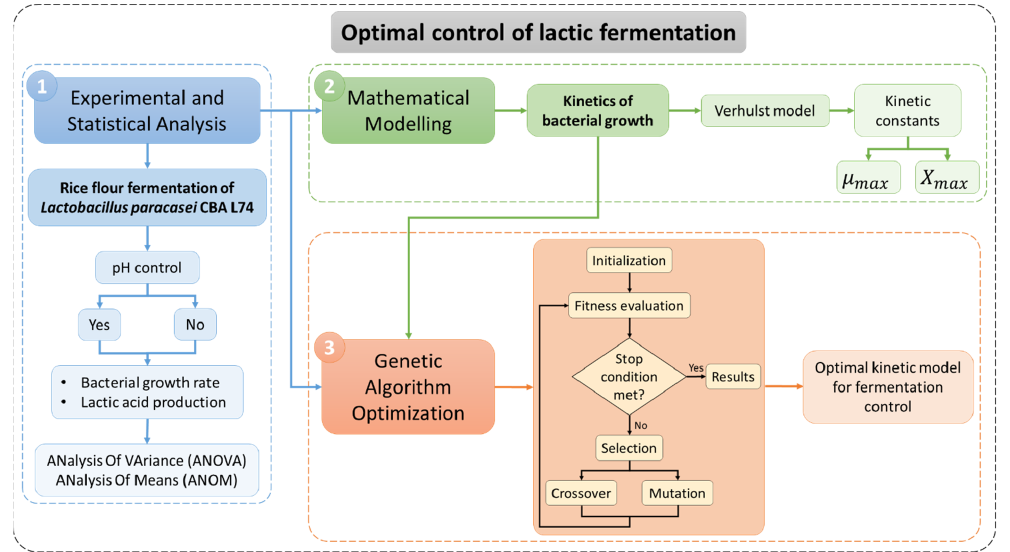
Figure 1. Flowchart of the activities carried out for the lactic fermentation optimization.